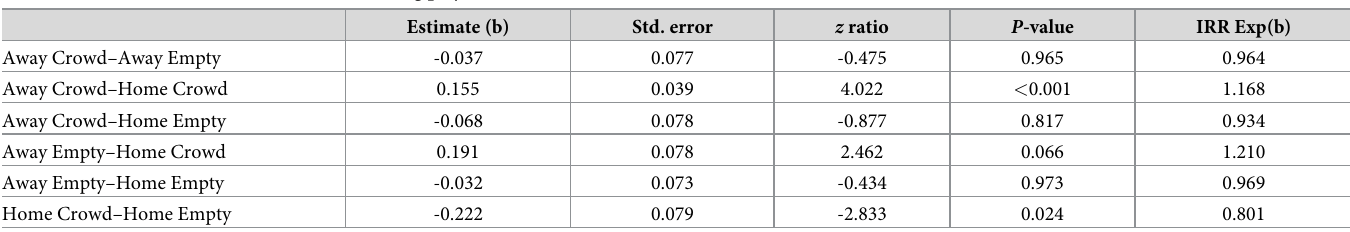
Table 3. Post-hoc results of the NHL model during playoffs ( n =